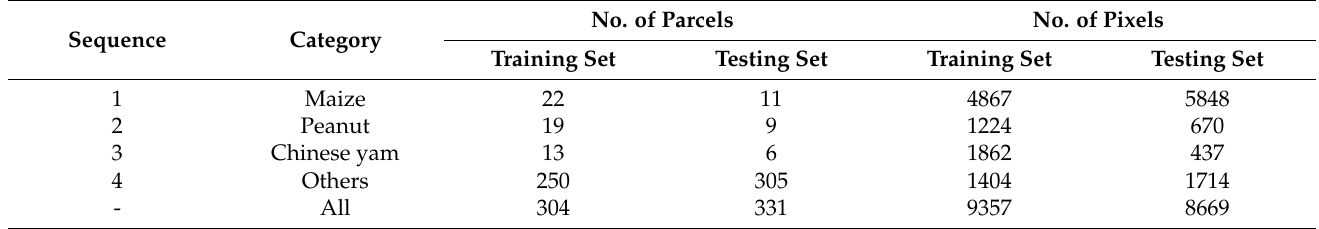
Table 5. Number of parcels and number of pixels for the training set and the testing